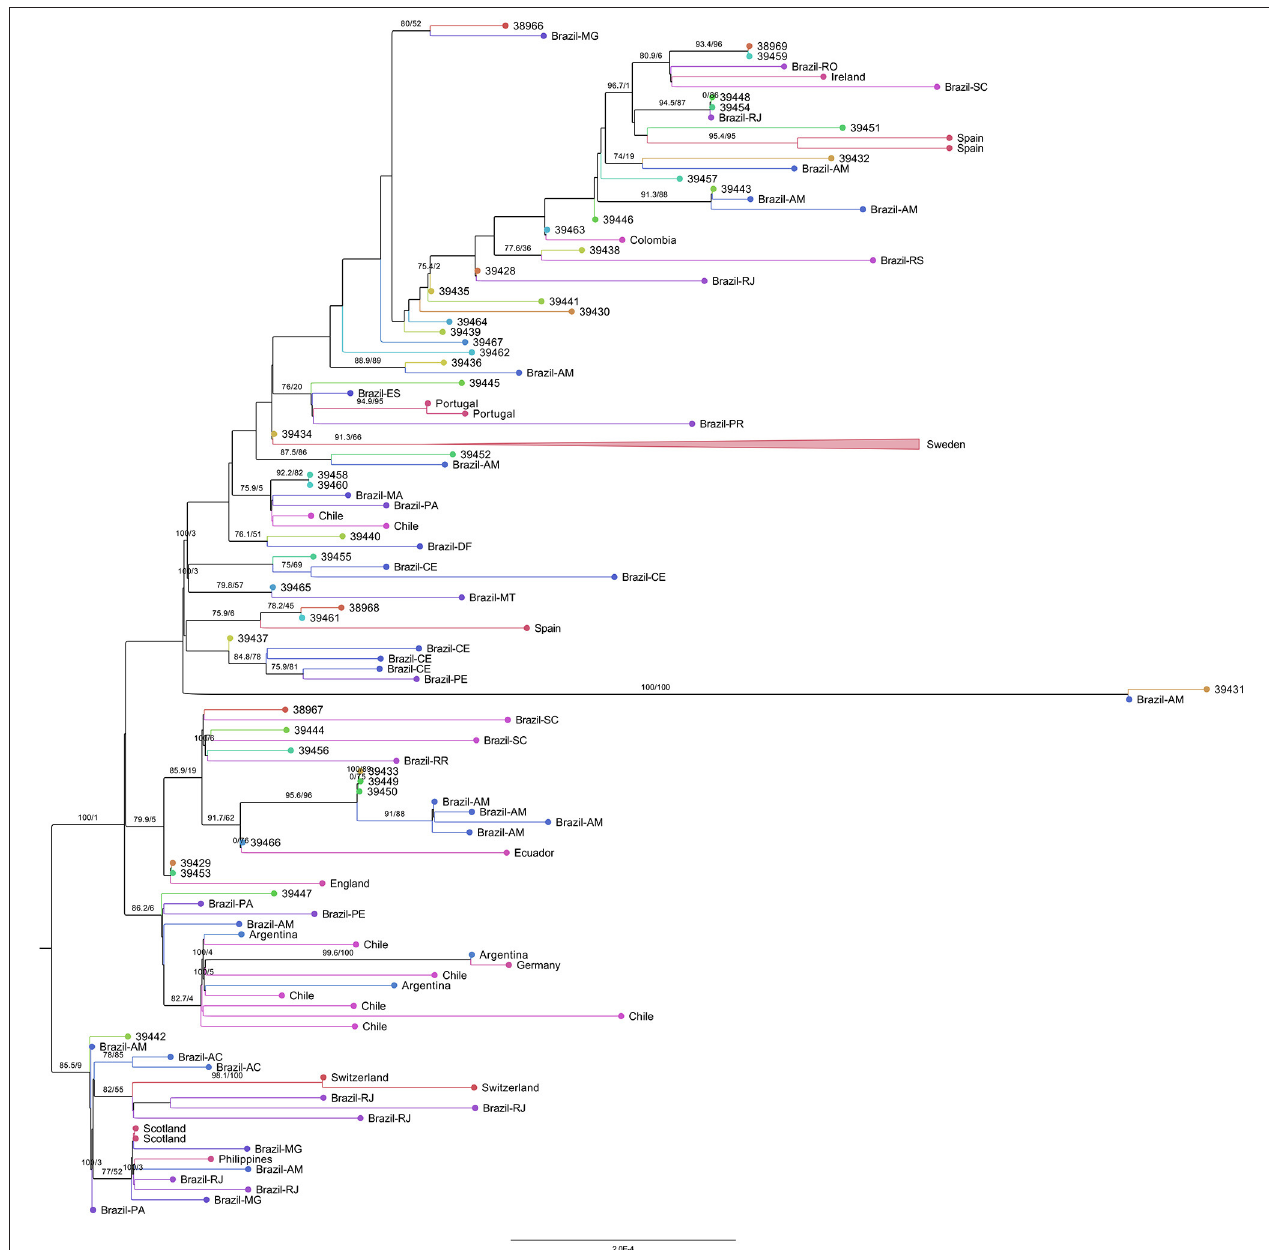
FIGURE 8 | Representative subtree of the 44 sequenced samples of this study and their nearest grouped neighbors inside the P.1 clade. The branch support values are represented by the SH-aLRT and ultrafast bootstrap percentages ≥ 70.